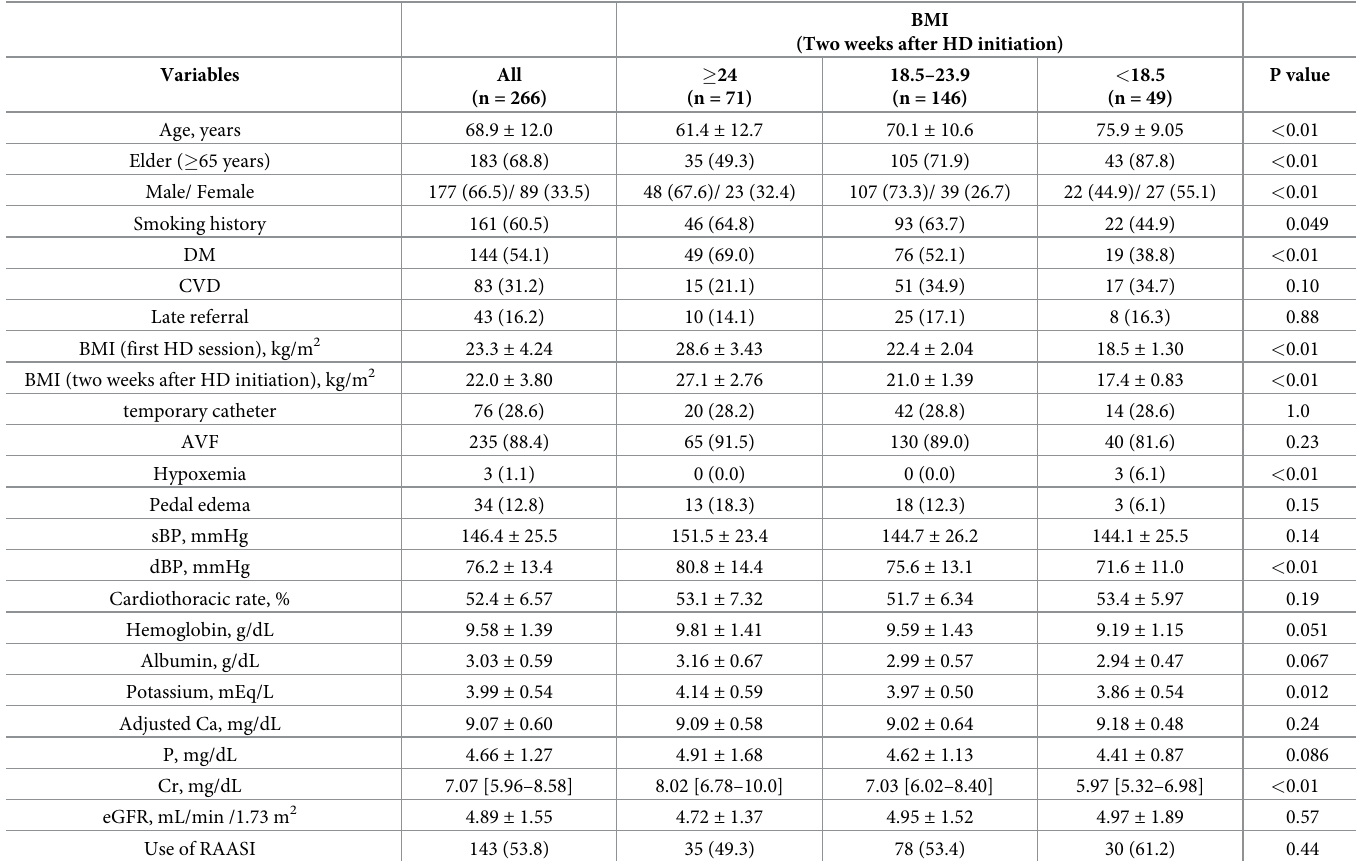
Table 2. Baseline clinical characteristics in 266 patients at 2 weeks after HD